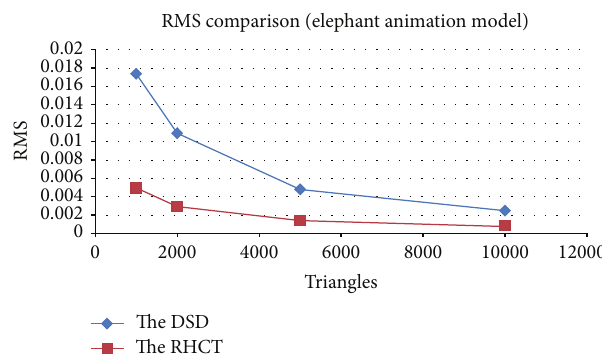
Figure 13: RMS error comparison for simplifying elephant animation model.